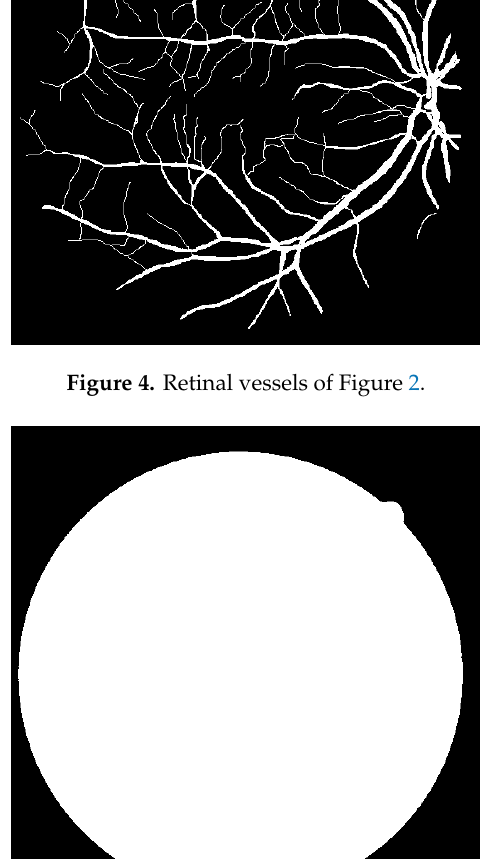
Algorithm 1 Procedure of the proposed method